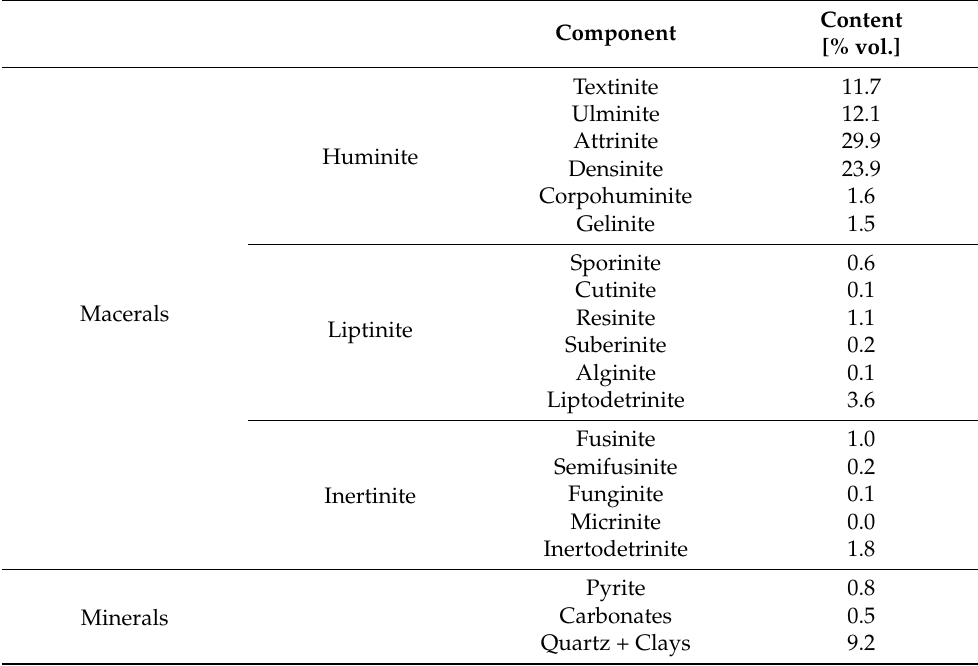
Table 2. Petrographic composition of lignite from the “Szczerc ó w” deposit [49].